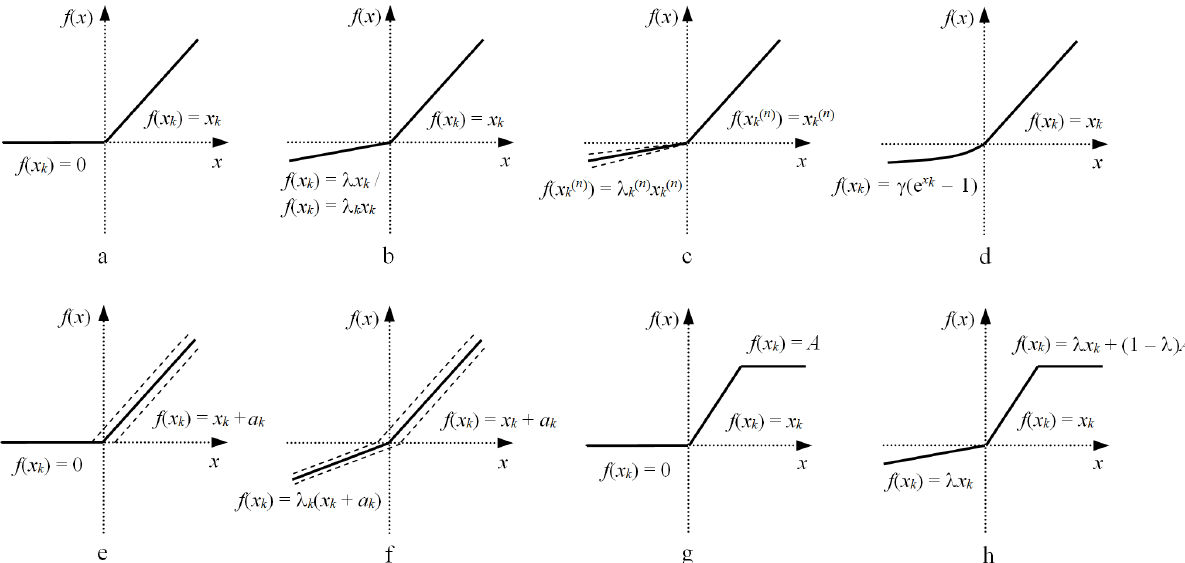
Figure 1. The ReLU activation functions: a ReLU, b LReLU/PReLU, c RReLU, d ELU e RT-ReLU, f RT-PReLU, g bounded ReLU, h bounded LReLU